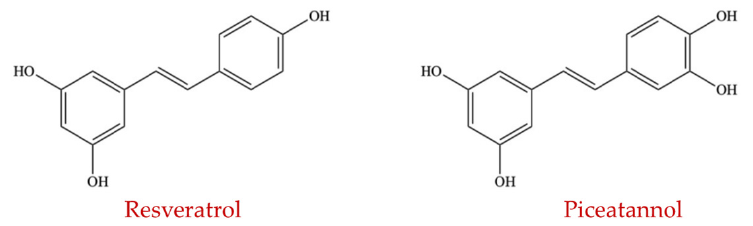
Figure 14. Chemical structures of resveratrol and piceatannol (self-generated). Resveratrol